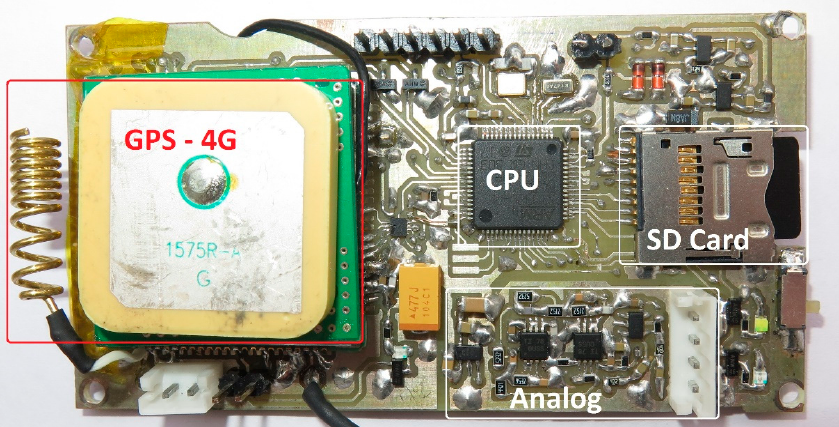
Figure 3. The recorder prototype. We circle and annotate the main components of the recorder. ‘Analogue’ denotes analogue amplification and low pass filtering using the micro-power operational amplifiers OPA313 (Texas Instruments, Dallas, TX, USA). Sensors 2019 , 19 , x FOR PEER REVIEW